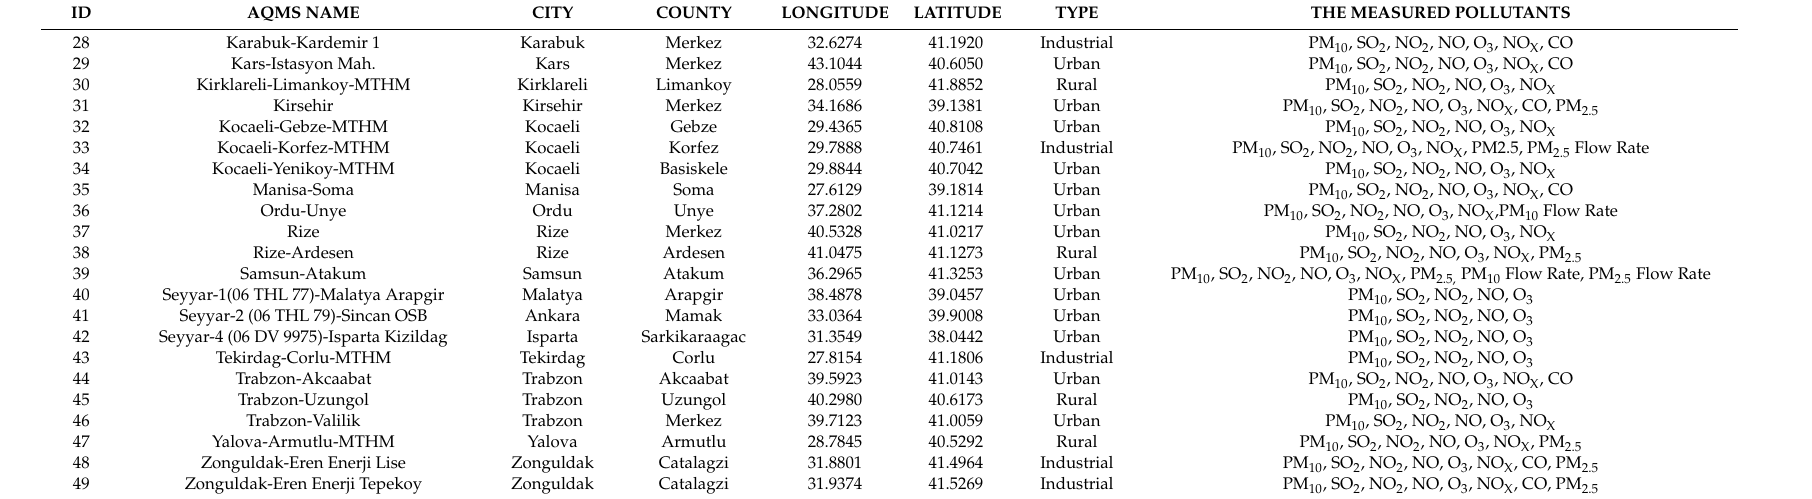
Table 7. The selected air quality monitoring stations (AQMS) and their